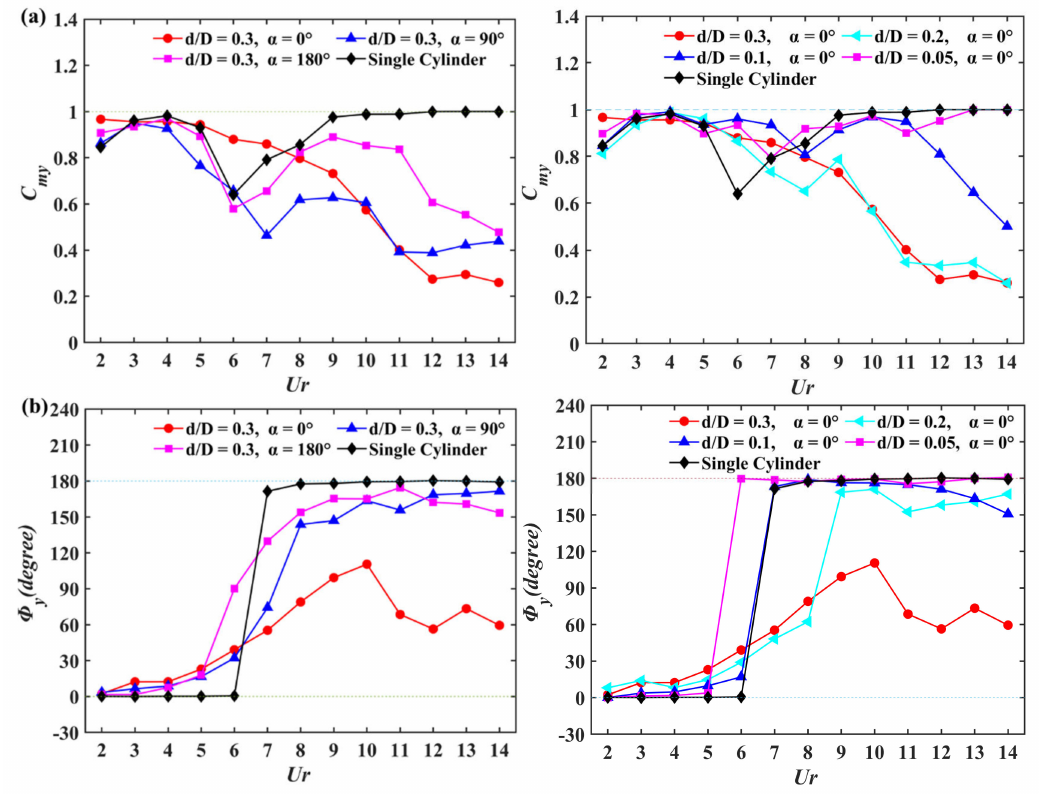
Figure 6. The correlation coefficient and the phase difference between the transverse vibration amplitude and lift force: ( a ) the correlation coefficient; ( b ) the phase